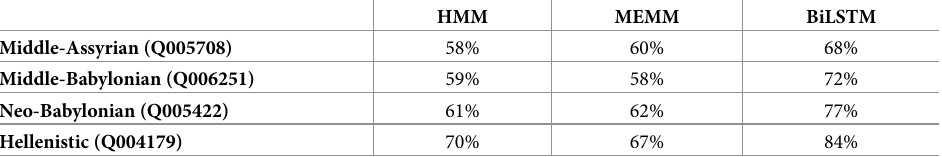
Table 3. Accuracy on